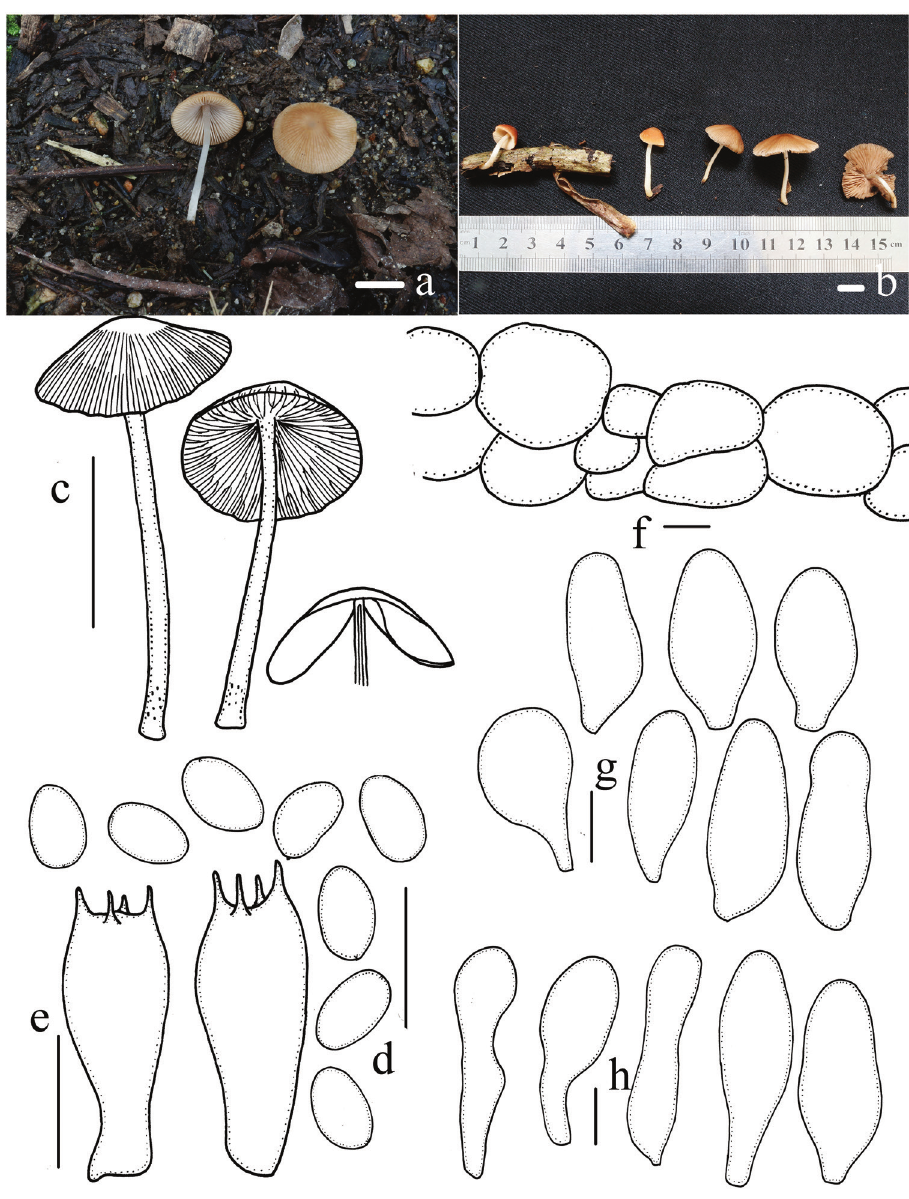
Figure 3. Basidiomata and microscopic features of Candolleomyces subminutisporus a–c Basidiomata d spores e basidia f pileipellis g cheilocystidia h caulocystidia. Scale bars: 10 mm ( a–c ); 10 μm ( d–h